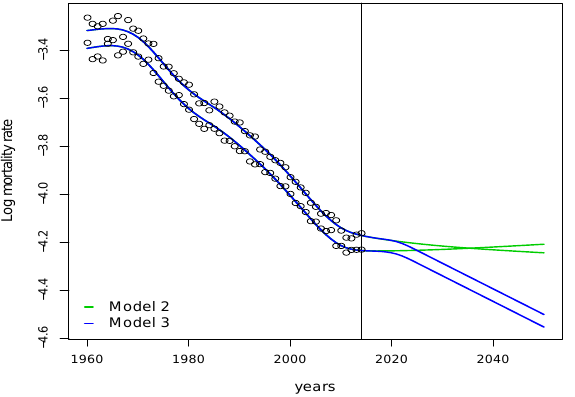
Figure 3. Fit and forecast for ages 66 and 67 obtained through model 2 (green line) and model 3 (blue line). Model 3 prevent cross-over for ages. The vertical line indicates the year from which we predict